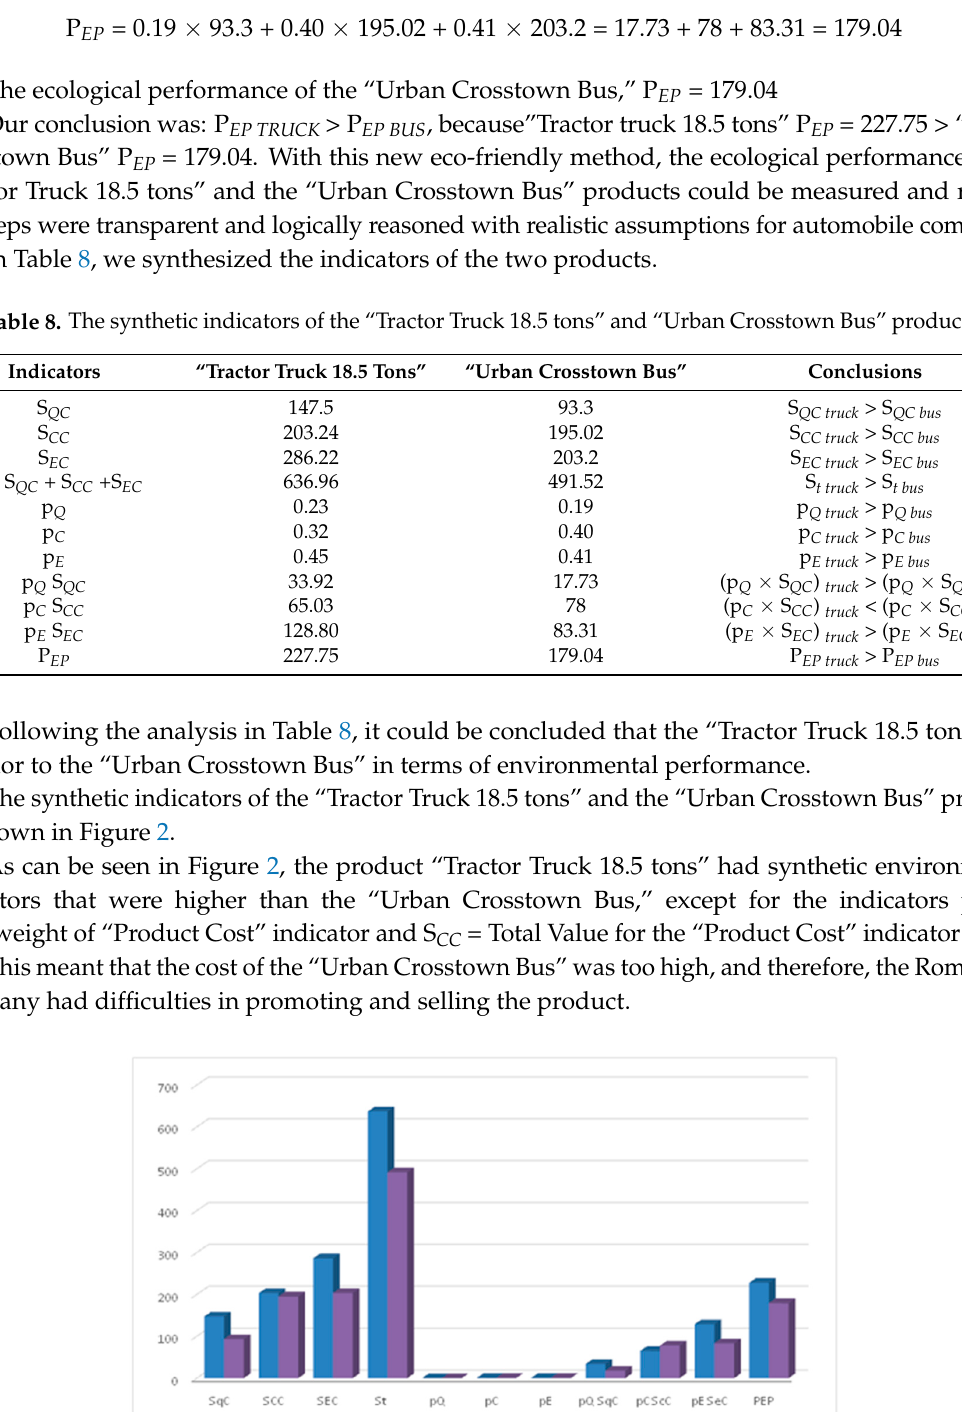
Table 8. The synthetic indicators of the “Tractor Truck 18.5 tons” and “Urban Crosstown Bus” products.